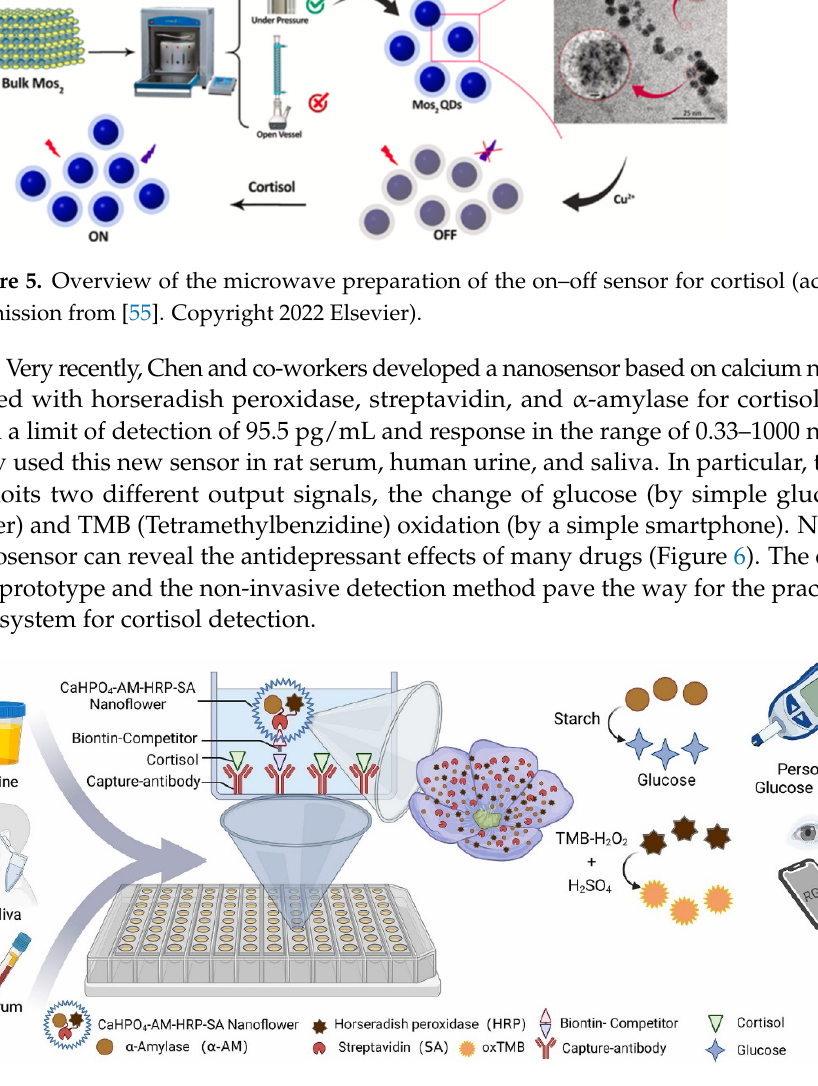
Figure 5. Overview of the microwave preparation of the on–off sensor for cortisol (adapted with permission from [55]. Copyright 2022 Elsevier).